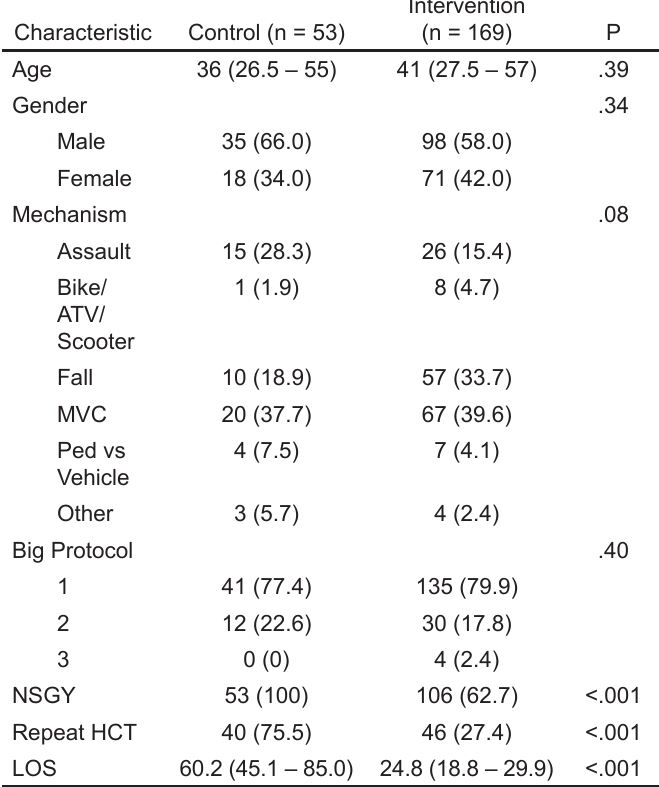
Table 3. Patient characteristics.